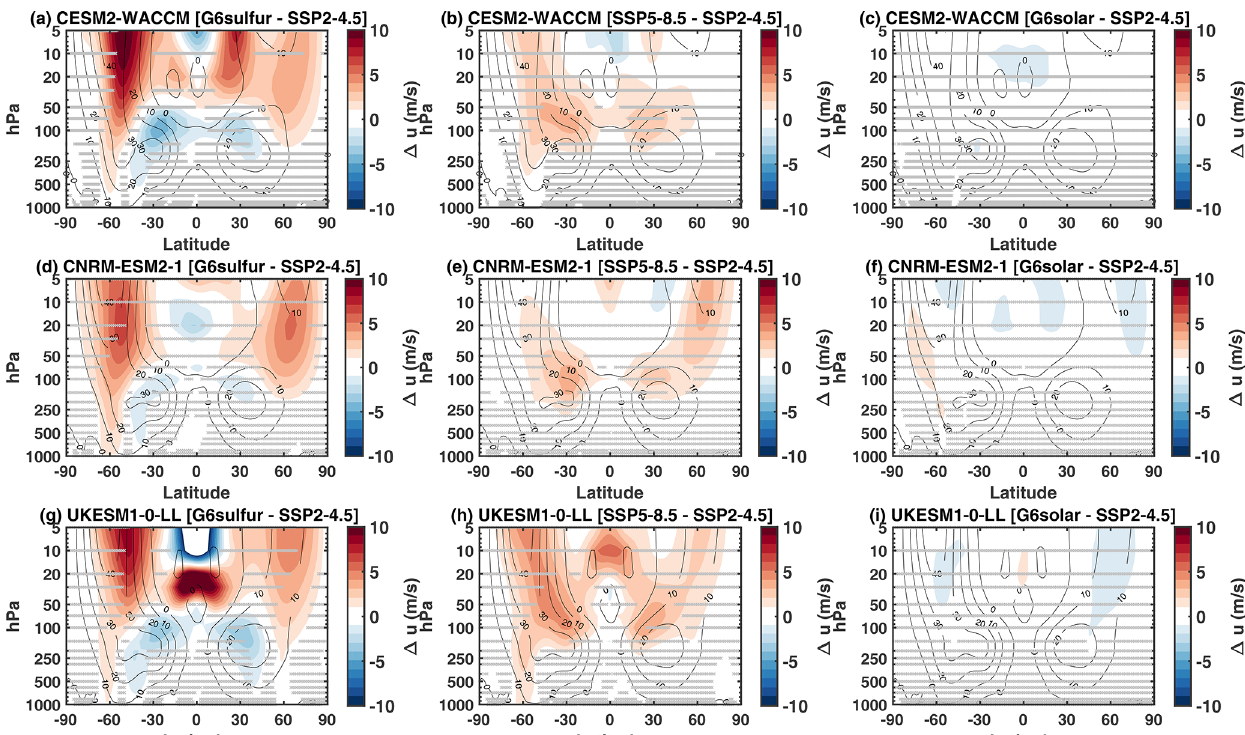
Figure A1. Zonal mean zonal wind changes (ms − 1 ; 2080–2089) between G6sulfur and SSP2-4.5 (a, d, g) , SSP5-8.5 and SSP2-4.5 (b, e, h) , and G6solar and SSP2-4.5 (c, f, i) for the three GeoMIP models with interactive chemistry that participated in the G6 experiment. Contour lines show the baseline SSP2-4.5 winds. Gray horizontal lines indicate changes that are not statistically significant over the temporal period considered when using a double-sided t test at 95% confidence